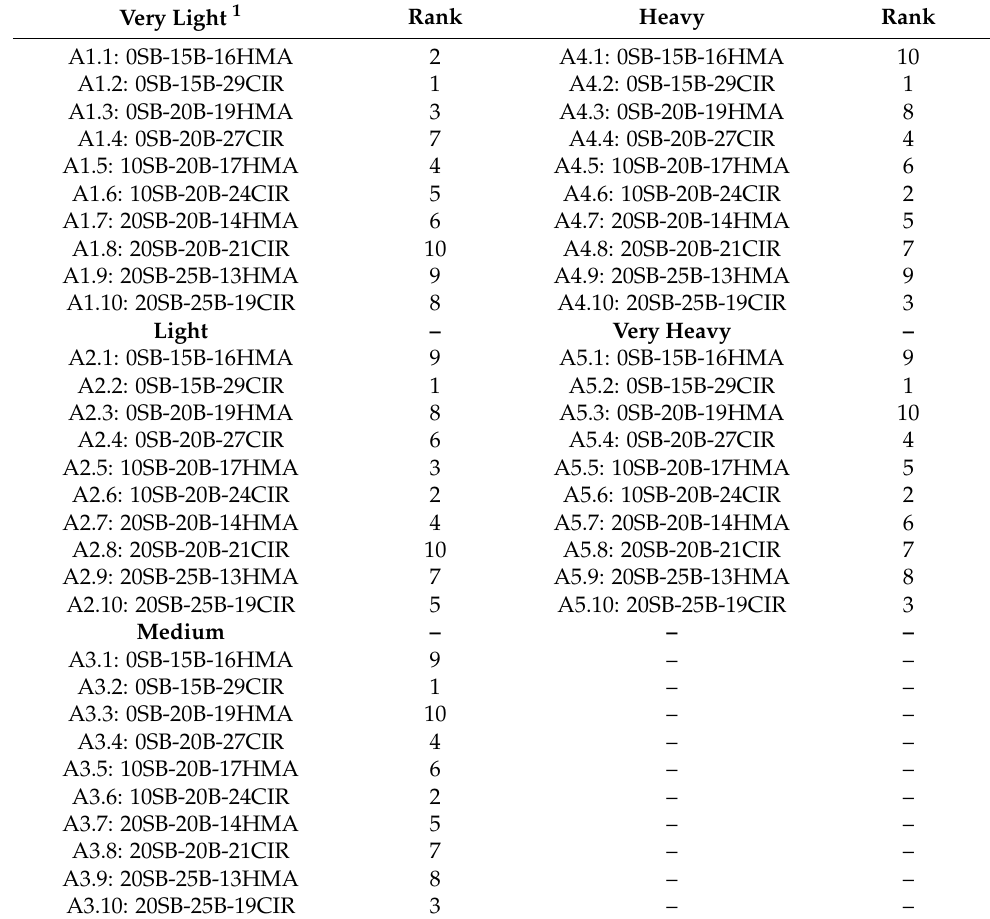
Table 4. Scenarios for all traffic classes. Very Light